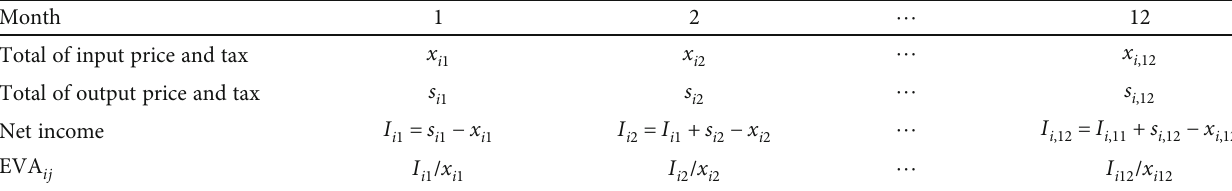
Table 1: Asset fl ow data of